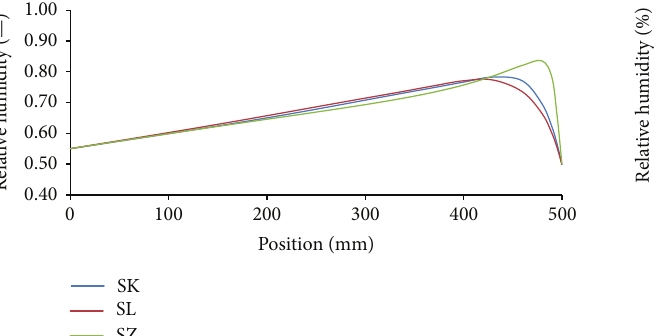
Figure 12: Relative humidity of air for SZ sandstone under Prague’s climatic conditions, January.